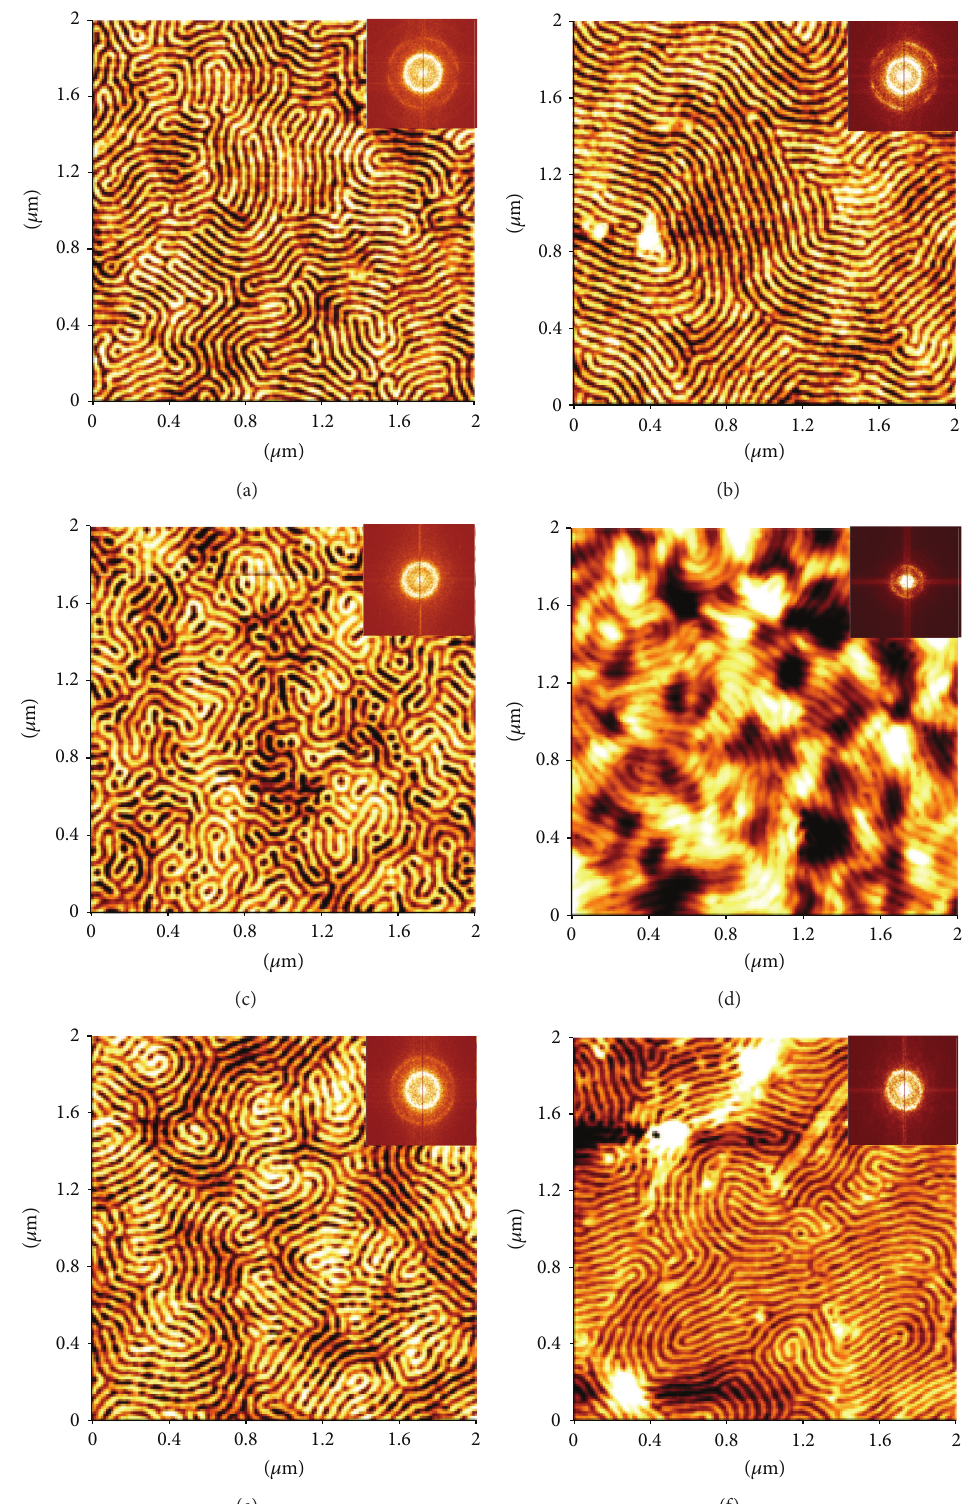
Figure4:AFMtopographyimagesofPS- b -PFSthinfilmsafterexposuretoTHFfor1 hatroomtemperaturepreparedfroma1.0 wt.%solution of the polymer on substrates of (a) Si 3 N 4 , (b) SiO